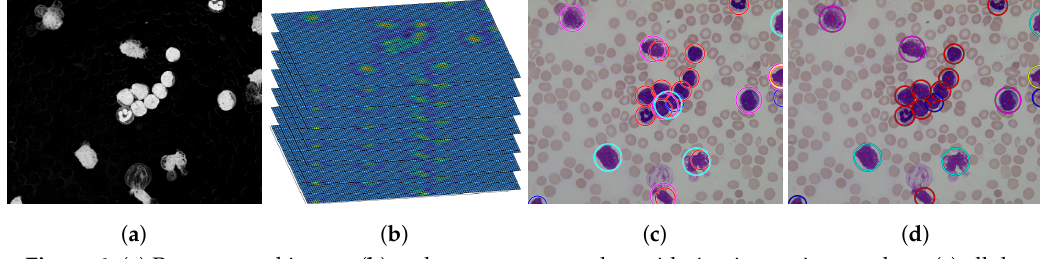
Figure 6. ( a ) Preprocessed image, ( b ) scale-space generated considering increasing σ values, ( c ) all the detected blobs at different scales obtained from the strongest local maxima, and ( d ) detected blobs after non-maxima suppression.